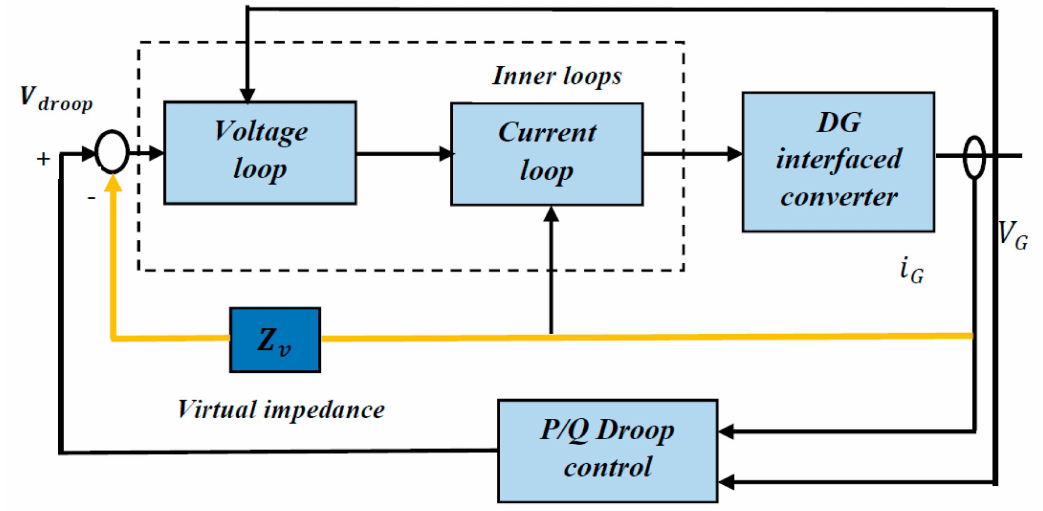
Figure 3. P / Q method visualization. E and ω are the voltage amplitude and the frequency, with E * and ω * their references. G p ( s ) and G q ( s ) are linear transfer